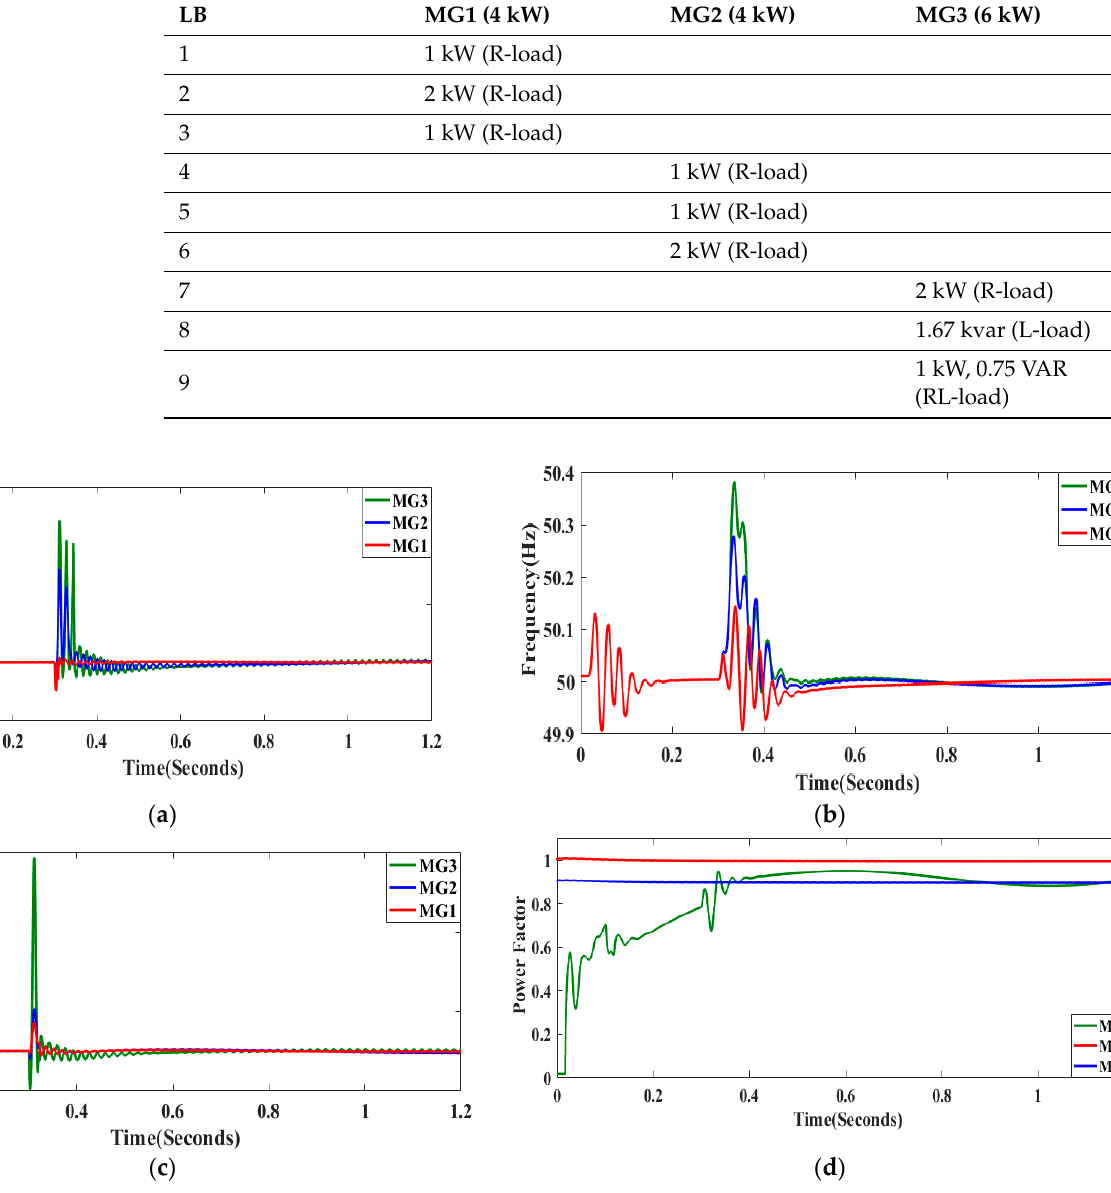
Figure 21. ( a ). Voltage deviation of complex MG with the effect of the switching delay. ( b ) THD of complex MG with the effect of the switching delay. ( c ) Frequency of complex MG with the influence of the switching delay. ( d ) PF of complex MG with the effect of the switching delay.